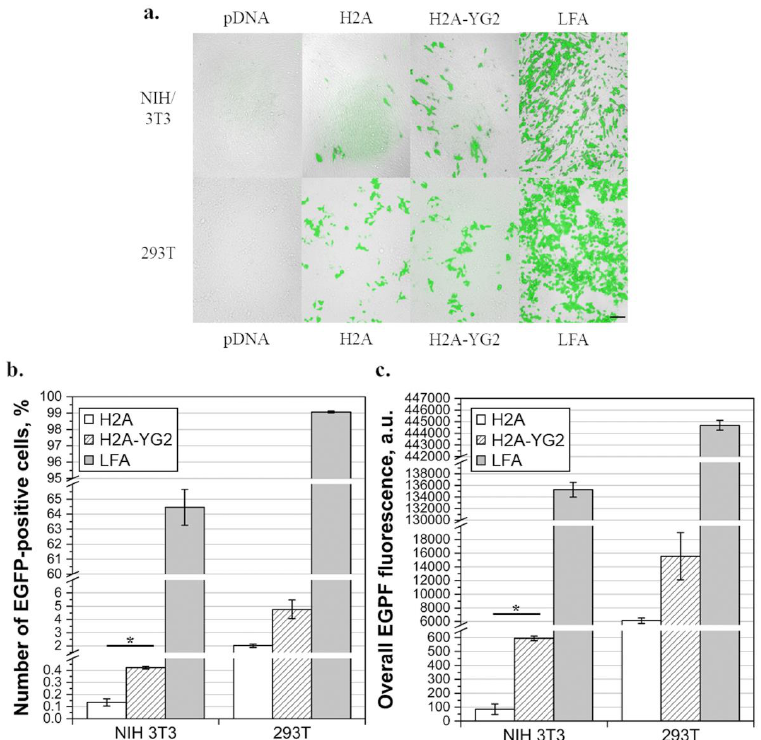
Figure 5. EGFP (enhanced green fluorescent protein) production in transfected cells. ( a )—Fluorescence microscopic images of transfected cells (combined microphotographs obtained using bright field and fluorescence microscopy in the GFP-fluorescence channel). Images of NIH/3T3 and 293T cells, following transfection with pCMV_EGFP_P2A_luc2 alone (pDNA), complexed with histones H2A (H2A) or H2A-YG2 (H2A-YG2) in N/P = 10, or Lipofectamine ® 2000 (LFA), are shown. Scale bar equals 100 µm and is applicable to all images. ( b , c )—EGFP production analyzed using flow cytometry; the proportion of EGFP-positive cells ( b ) and overall EGFP fluorescence ( c ) in NIH/3T3 and 293T cells transfected with LFA and histones H2A and H2A-YG2 in N/P = 10, using pCMV_EGFP_P2A_luc2, are shown. Mean values (n = 2) are shown, error bars represent standard error (n = 2); * p < 0.05.